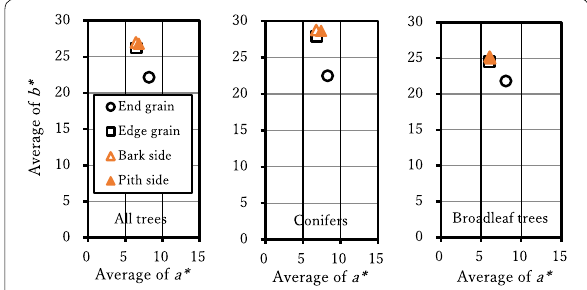
Fig. 5 Correlation diagrams between a* and b*